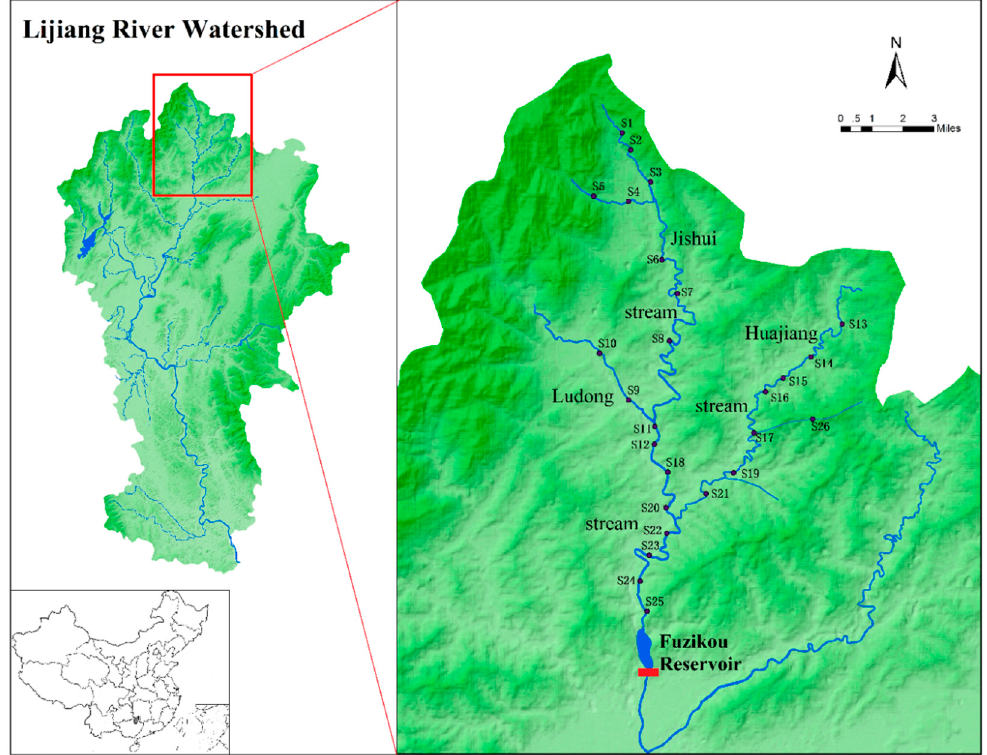
Figure 1. Study area and sampling sites in upstream of Lijiang River.